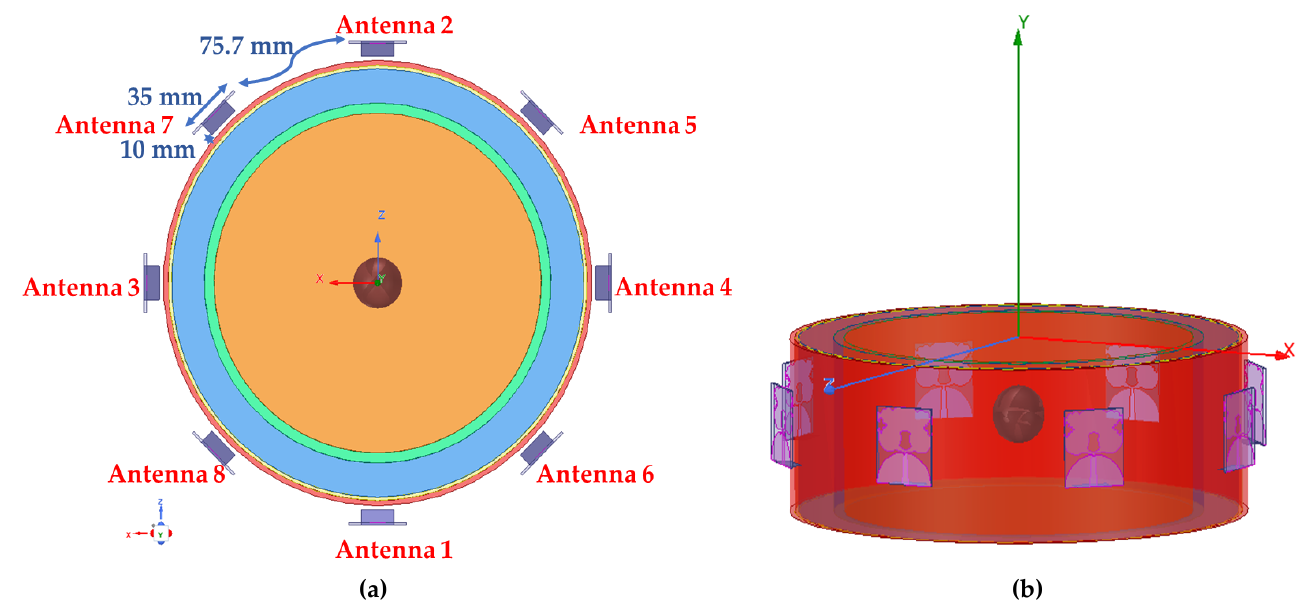
Figure 5. Eight-element array configuration around lung phantom: ( a ) Top view; ( b ) Trimetric view.